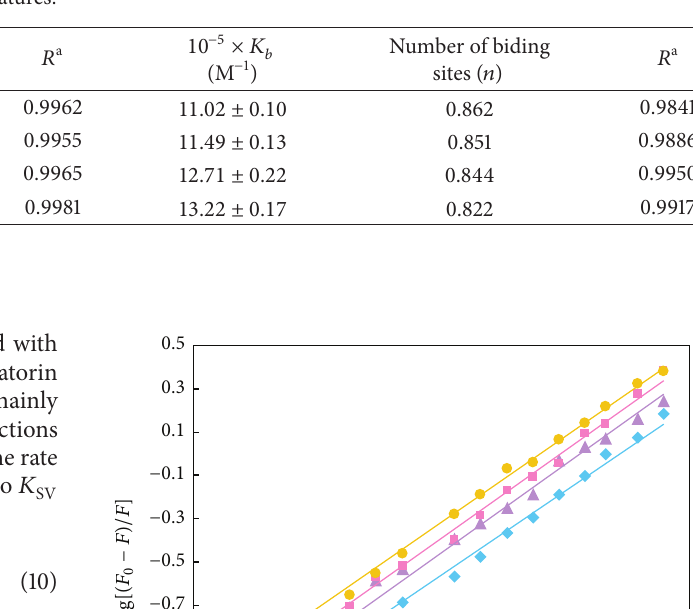
Table 1: Stern-Volmer quenching constant ( 𝐾 ), quenching rate constant ( 𝑘 𝑞 ), association constant ( 𝐾 𝑏 ), and number of binding sites ( 𝑛 ) SV for binding of isoimperatorin to HSA in the different temperatures.